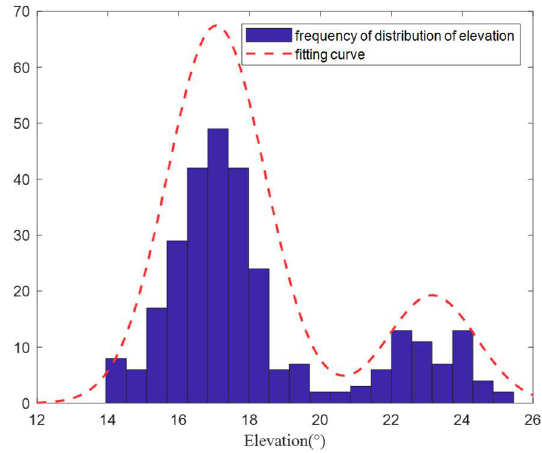
Figure 19. Statistical results for the elevation angle.